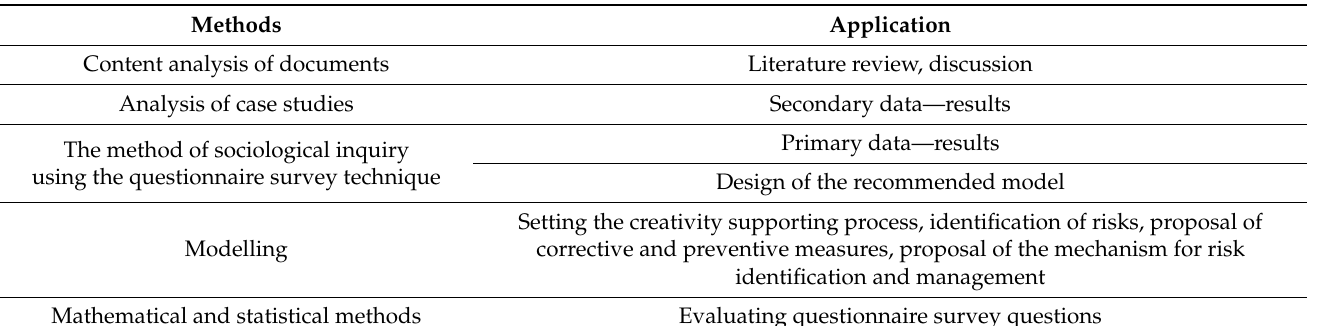
Table 1. Methods and their